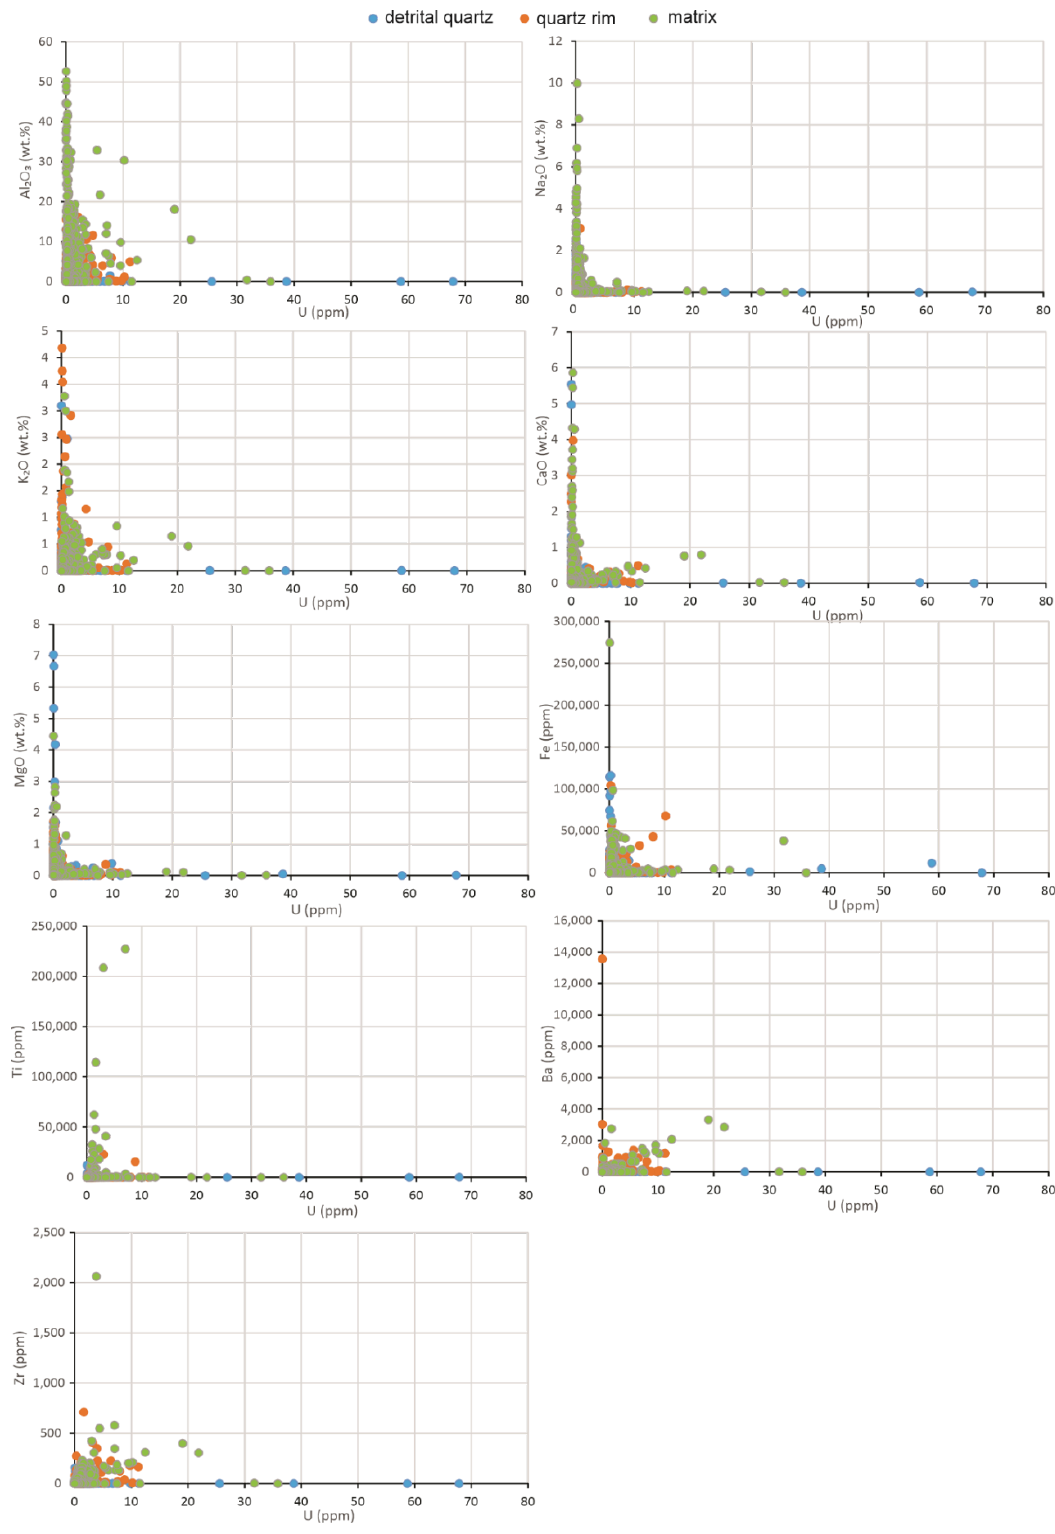
Figure 6. Bivariate diagrams showing poor correlations between U and Al, Na, K, Ca, Mg, Fe, Ti, Ba and Zr. Note the partial positive correlations between U and Ba, Zr, Al, K, Ca and Fe. Note also the low concentrations of these elements for the few spots that contain the highest U (>25 ppm).